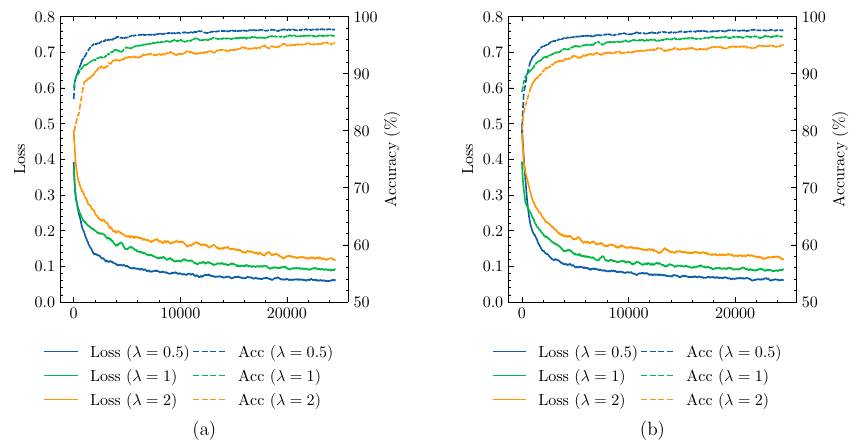
Figure 11. The network training accuracy and loss curves for the Bay Area and Santa Barbara datasets. ( a ) The Bay Area dataset. ( b ) The Santa Barbara